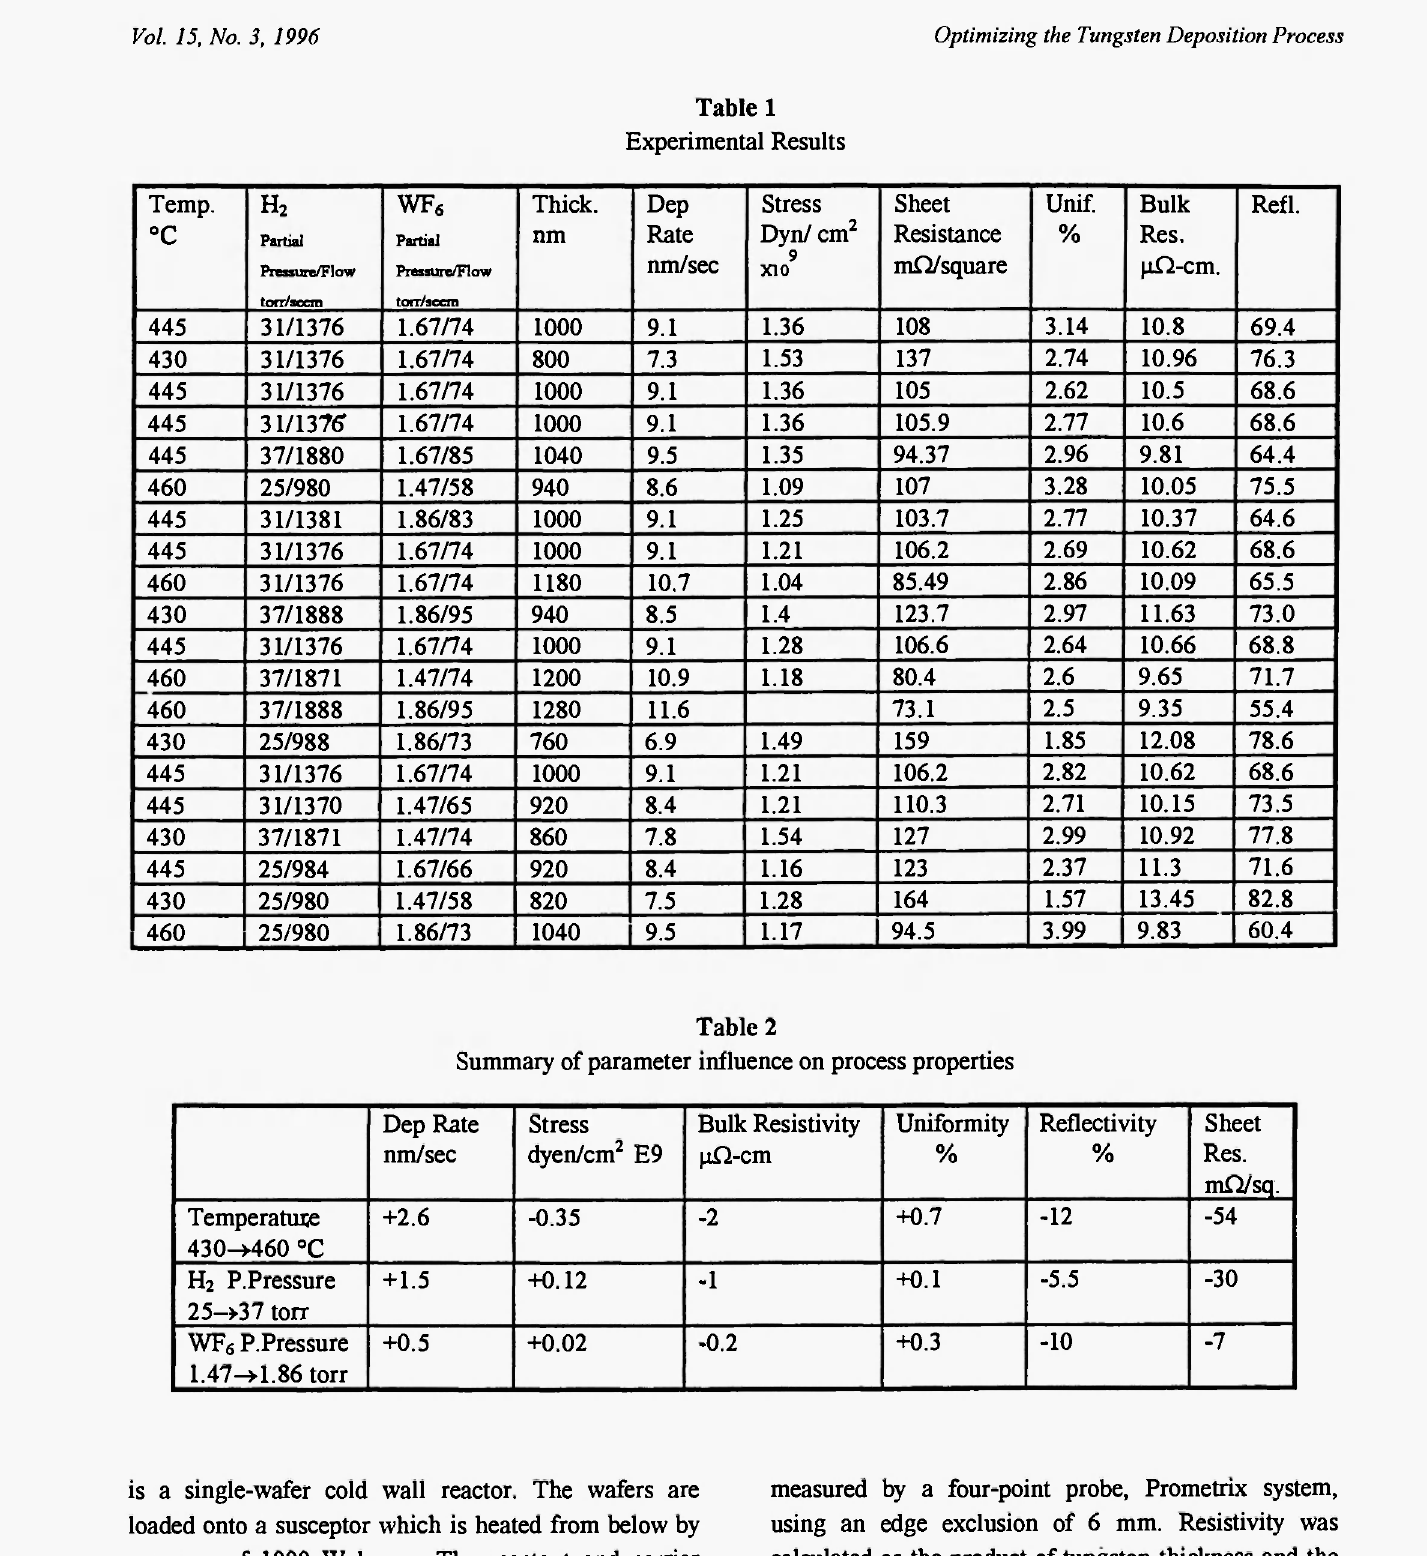
Summary of parameter influence on process